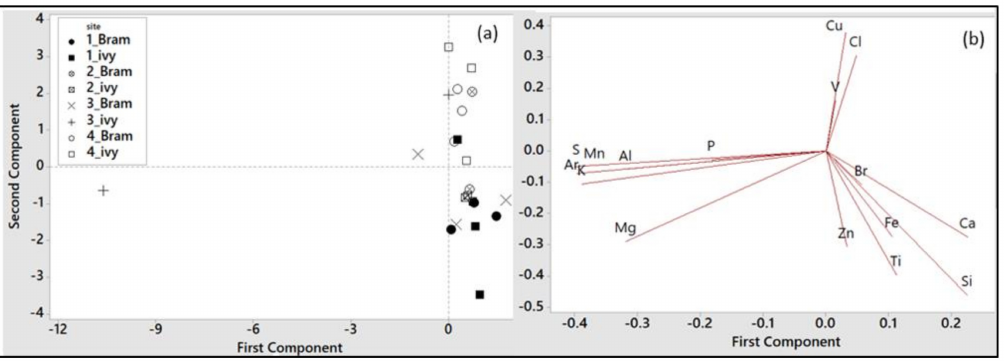
Figure 6. Principal component analysis; ( a ) scores plot with points representing sites and displaying site separation and ( b ) loading plot displaying relative loadings of variables. Site 1: Redbridge road; Site 2: Brinton’s Road; Site 3: The Avenue; Site 4: Southampton